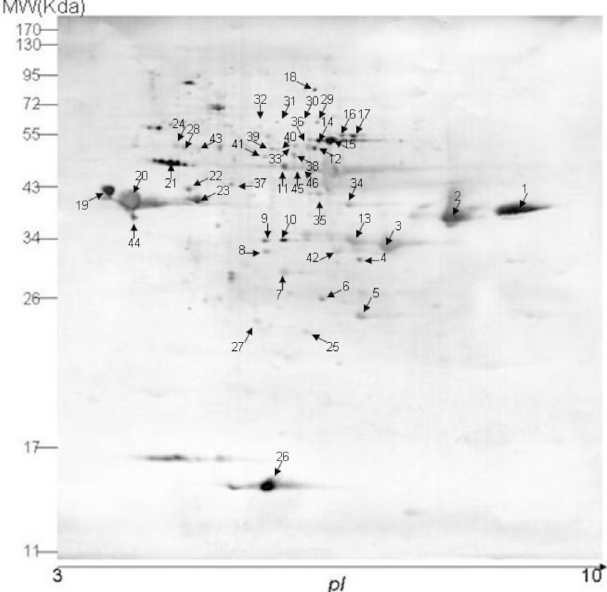
Figure 2. Immunoblot pro fi ling of unsporulated E. tenella oocysts using chicken anti- E. tenella